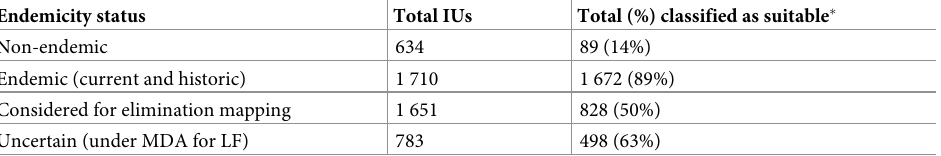
Table 1. Comparison of implementation unit (IU) classification using reported endemicity versus modelled envi- ronmental suitability